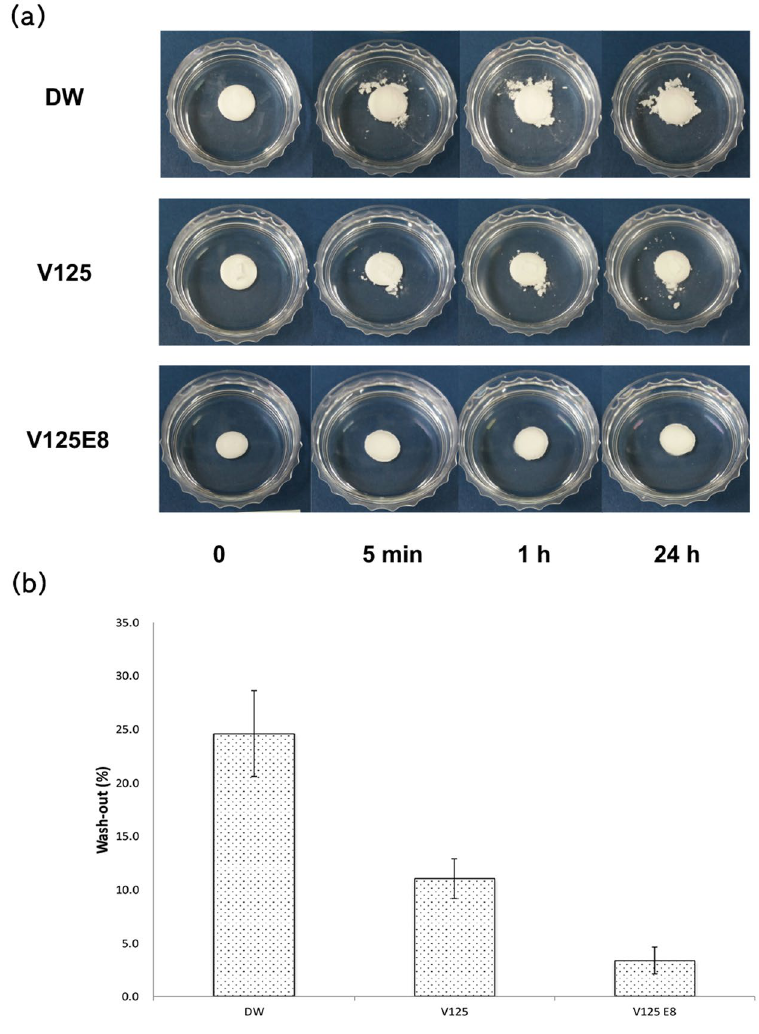
Figure 3. Washout resistance. Appearance ( a ) and the relative amount ( b ) of washed out cement. ELP/CPC composites showed greater washout resistance compared to DW. V125E8 samples tended to maintain their initial shapes; there was no obvious degradation during